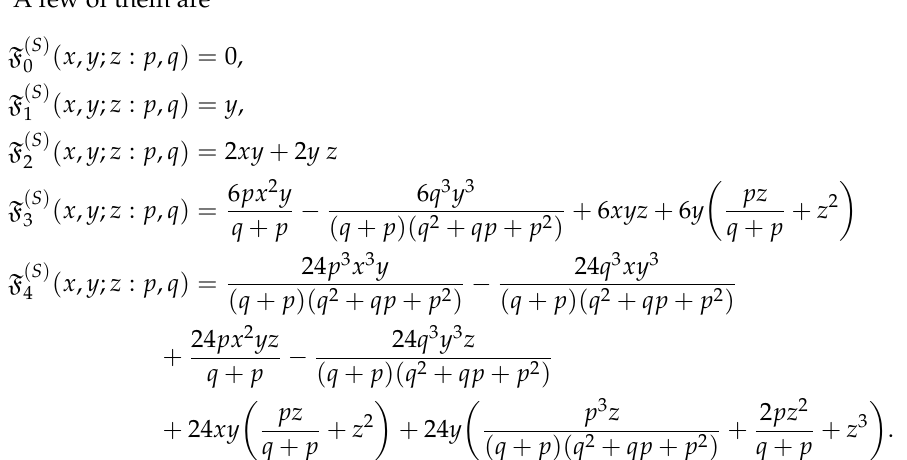
, 8 , 6 , 5 , q = 1 , 2 , 3 , 4 , y = 3 and z = 10 10 10 10 10 10 10 10